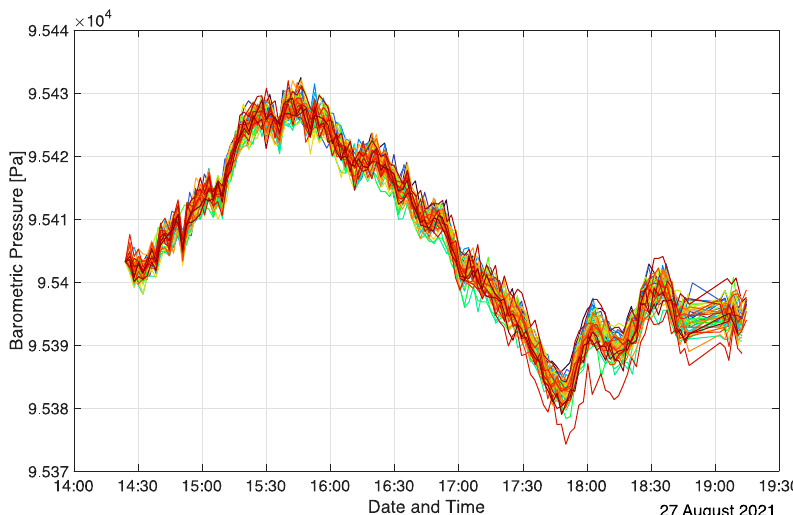
Figure 7. Calibrated barometric pressure readings in at-grade exam room. Sensor unit IDs are color- coded.